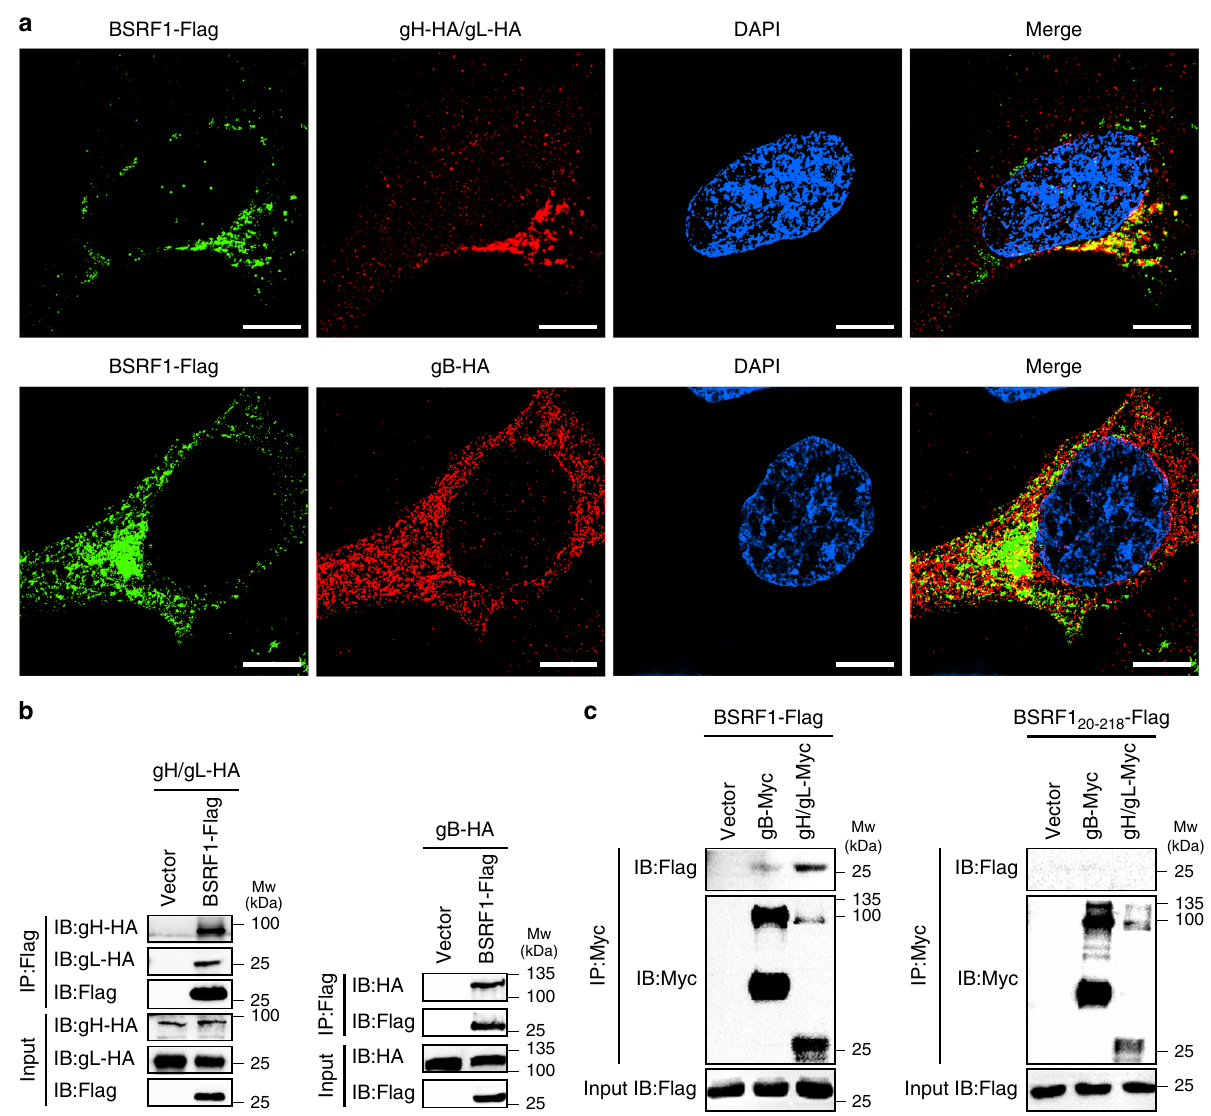
Fig. 7 BSRF1 associates with EBV glycoproteins. a BSRF1 co-localizes with EBV glycoproteins. Green, BSRF1-Flag; red, glycoproteins. Nuclei were stained with DAPI (blue). Scale bar, 5 μ m. b Flag-tagged BSRF1 co-immunoprecipitated with HA-tagged EBV glycoproteins in HEK293T cells. Source data are provided as a Source Data fi le. c Myc-tagged EBV glycoproteins co-immunoprecipitated with Flag-tagged BSRF1 and BSRF1 20 − 218 . Source data are provided as a Source Data fi le. Each experiment was repeated three times independently with similar